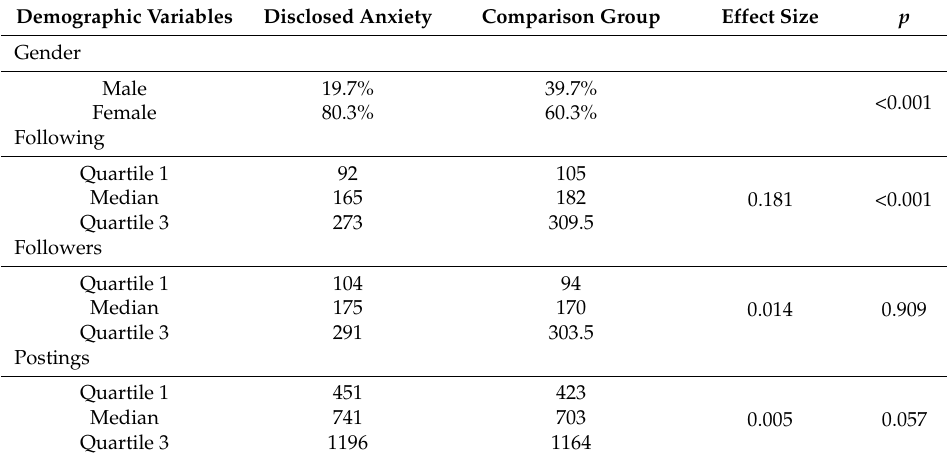
Table 2. Demographic characteristics of